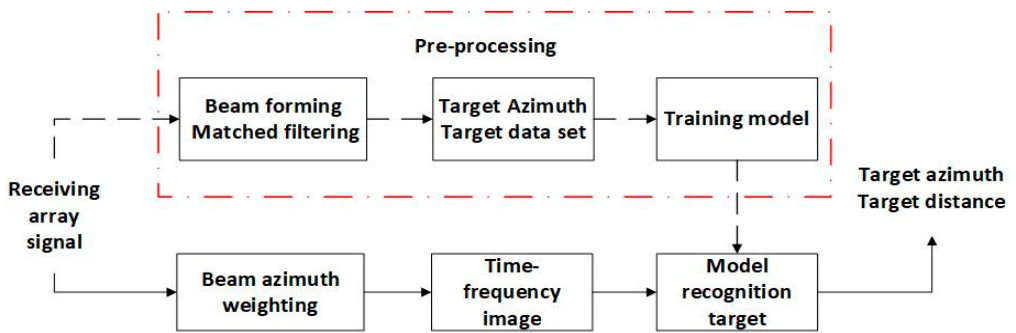
Figure 1. DCNN-KFAT flow chart. The preprocessing step detects the target and generates the target data set, and trains to obtain the model; in the follow-up tracking process, the generated signal time spectrogram with different azimuth weights is recognized by the trained model; finally the target azimuth and distance are obtained.